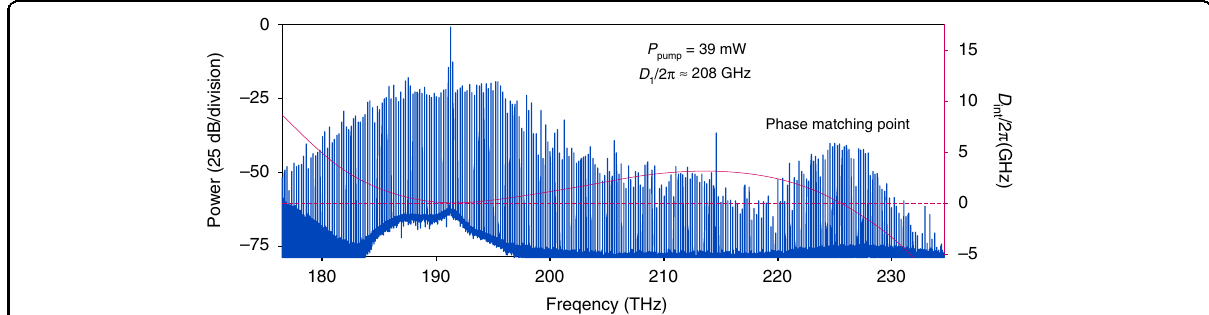
Fig. 2 Generated frequency comb spectrum with the pump power of 39 mW. The pink solid line plotted the integrated dispersion D int = 0 from FEM simulation according the microresonator geometry. The phase matching point revealed from the simulations, where D int = 0, agrees with the spectral position where enhanced comb line power is